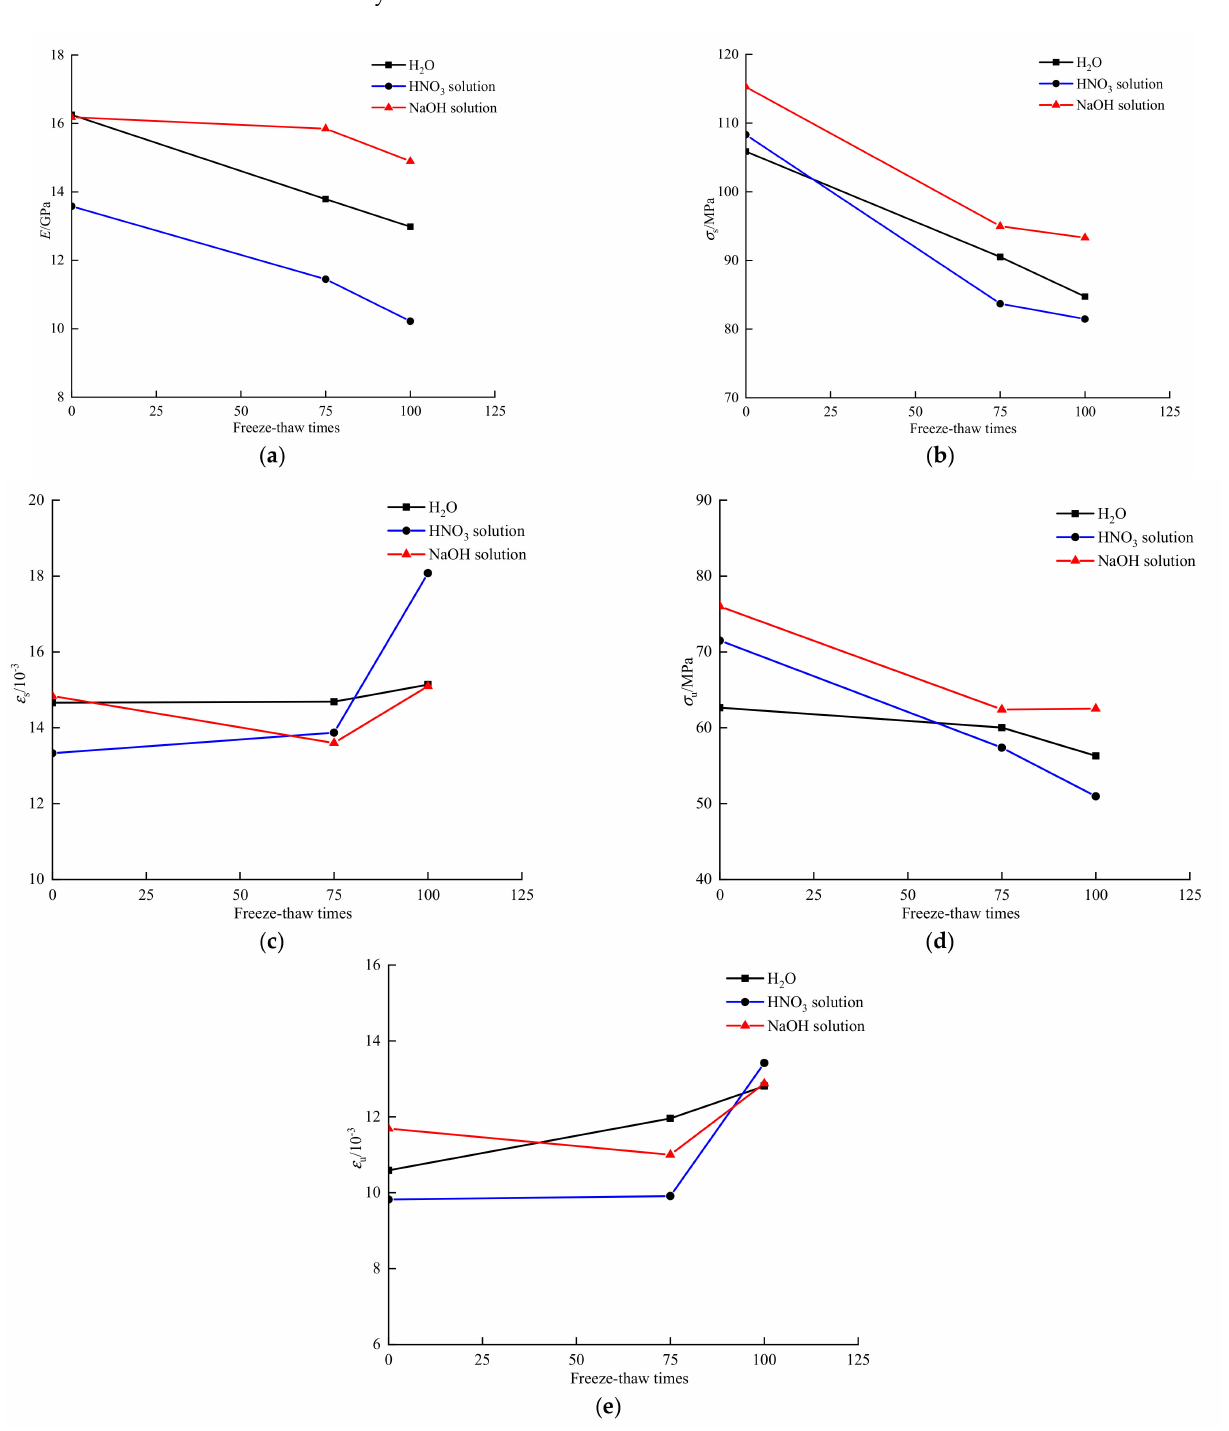
Figure 4. Changes of rock parameters under different chemical solutions and freeze-thaw cycles: ( a ) Elastic modulus; ( b ) Peak stress; ( c ) Peak strain; ( d ) Threshold stress; ( e ) Threshold